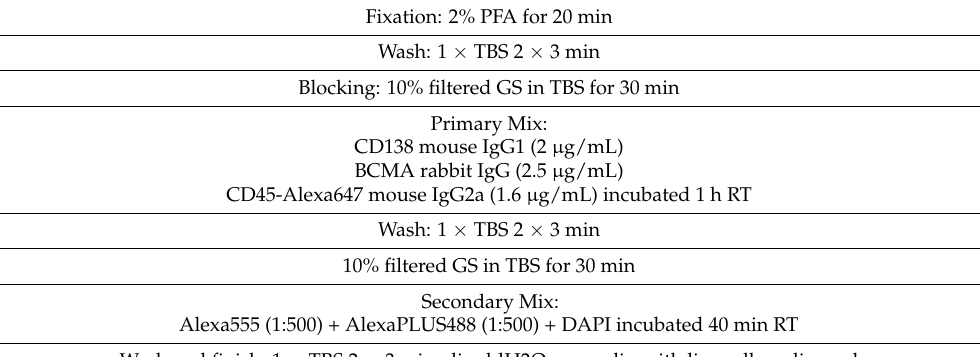
Table 2. BCMA assay staining protocol. RT = room temperature; GS = goat